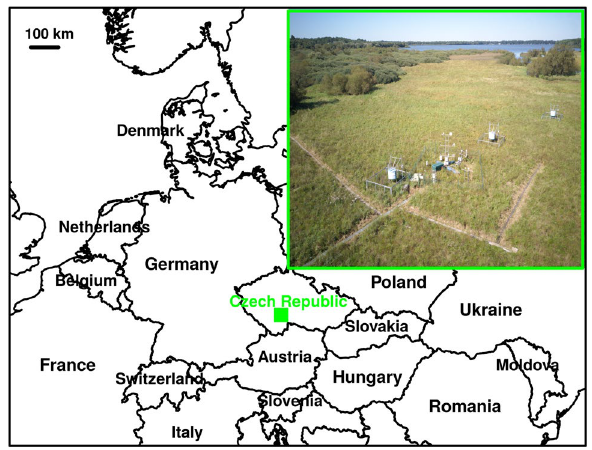
Figure 1. Location of the “Wet Meadows” study site in the Czech Republic (Europe) and picture of the sedge- grass marsh with scientific infrastructure of ICOS (http://www.europ e-fluxd ata.eu/icos/home) and Fluxnet (http://sites .fluxd ata.org/CZ-wet/) flux networks. The map was drawn using the R packages 27 “rworldmap” version 1.3-6 (https ://cran.r-proje ct.org/web/packa ges/rworl dmap/).